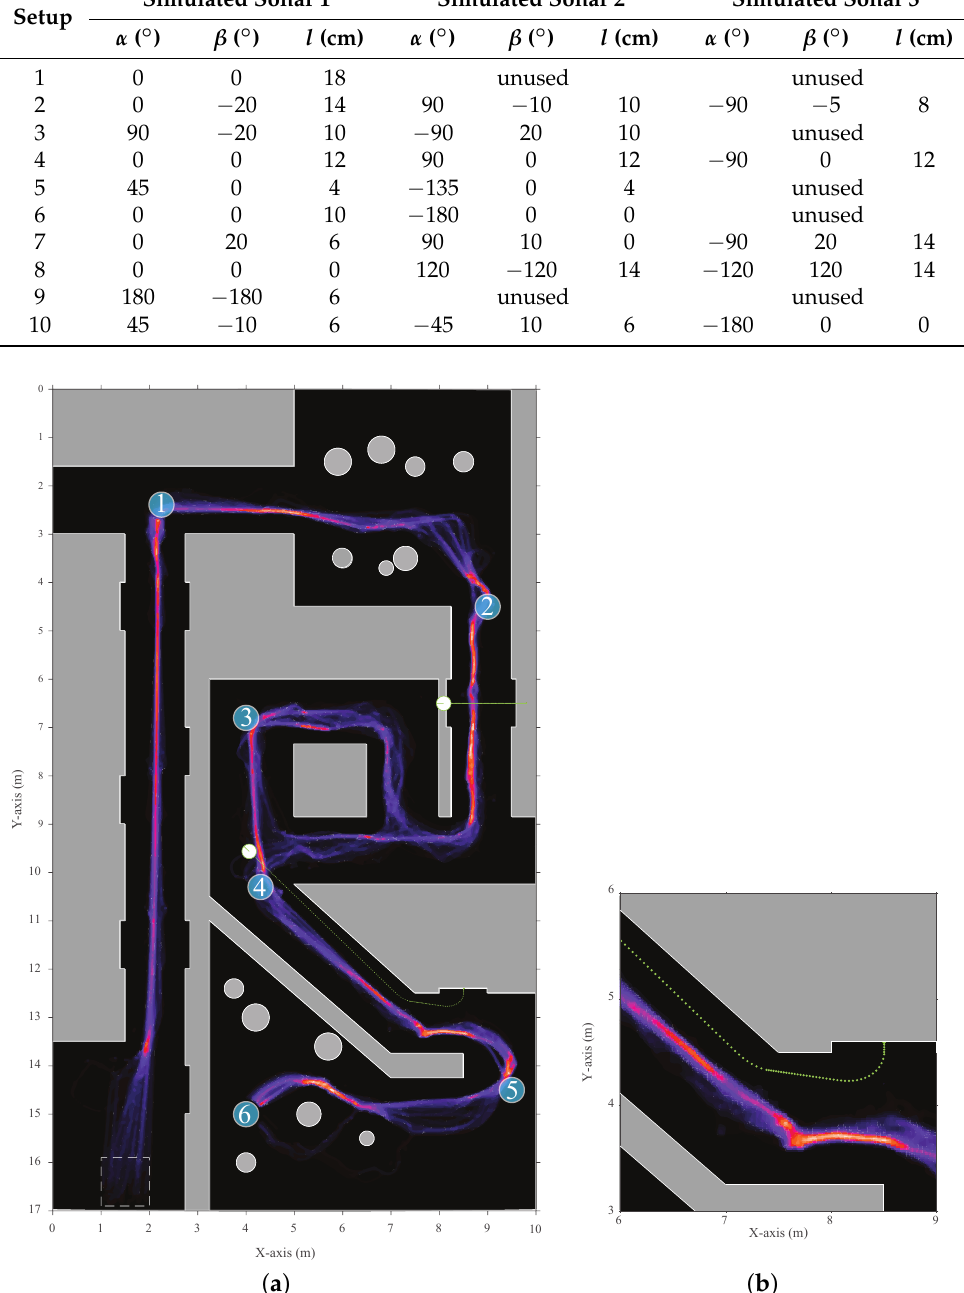
Figure 9. ( a ) A heat map of the trajectory distribution of the simulated scenario. It was taken over ten multi-sonar configurations. Each configuration was run 15 times for a total of 150 trajectories. The start zone, indicated as a rectangle with dashed edges, was the location where the starting position is chosen at random. Afterwards, the mobile platform would start moving between the sequential waypoints (shown as the blue numbered circles 1 to 6) based on the local layered navigation controller and global waypoint navigator. ( b ) A more detailed highlight of an area where a dynamic object interfered with the mobile platform path. This shows the adjustment the navigation controller made to avoid the dynamic object more